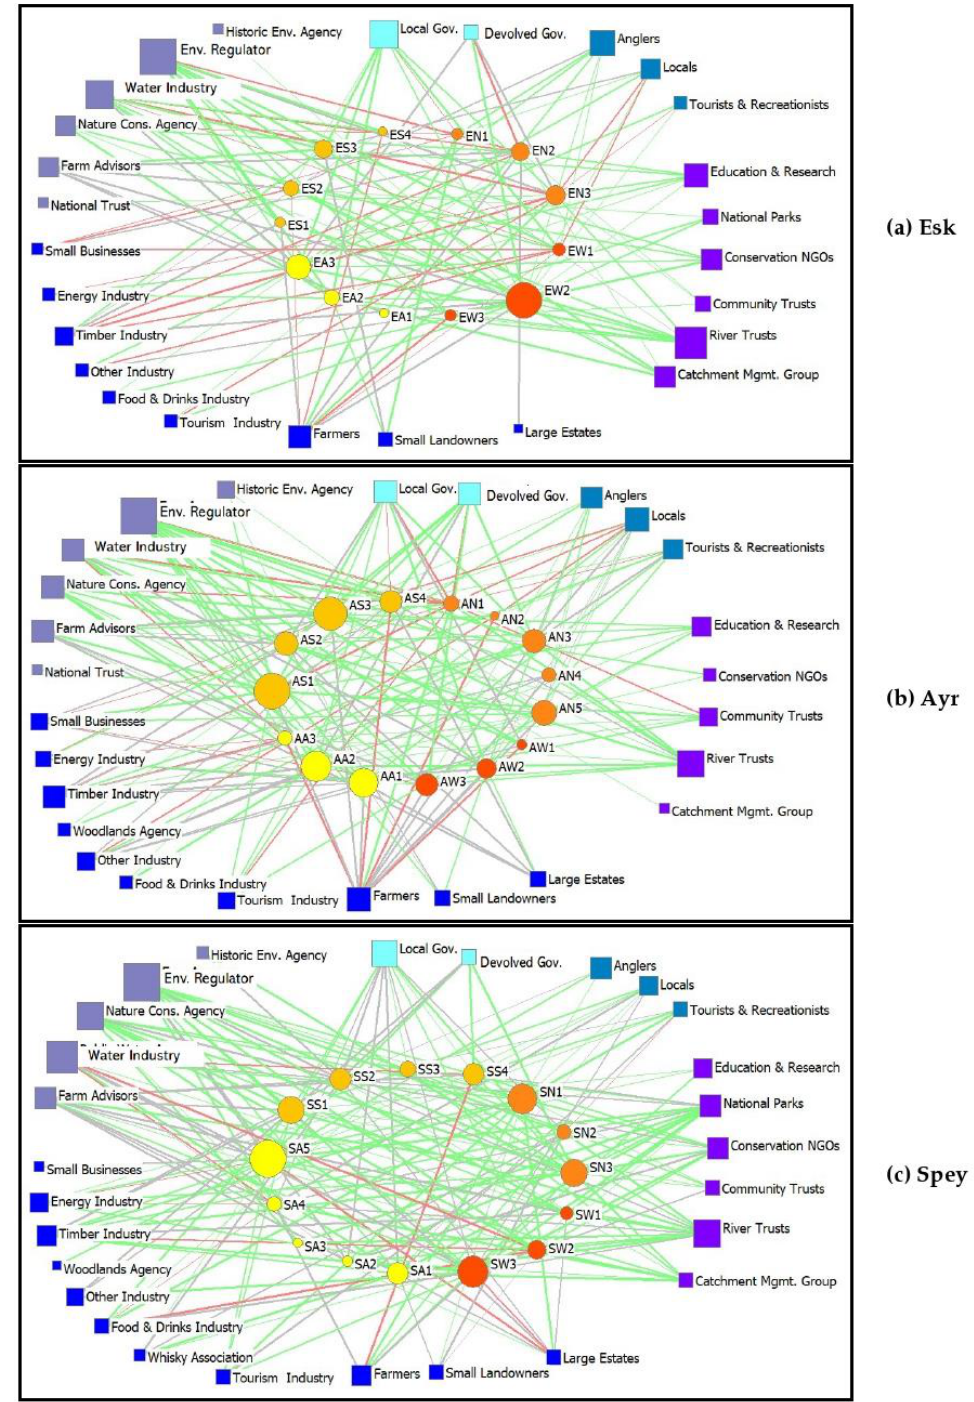
Figure 7. Two-mode networks of the ( a ) South Esk, ( b ) Ayr and ( c ) Spey catchments. Depicting responses of stakeholder typologies (squares, coloured to distinguish government (turquoise), public bodies (grey), private business (blue), other stakeholders (purple) and individual actors (cyan)) by individual participants (circles, yellow (Catchment Scientists; i.e., EA1 – 3), amber (Environmental Regulators; i.e., ES1 – 4), light orange (Farm Advisors; i.e., EN1 – 3) and dark orange (Water Industry staff; i.e., EW1 – 3)) with tie strength depicting a small, medium or large influence on the catchment and tie colour showing a negative (red), neutral (grey) or positive influence (green). Node size depicts degree score.